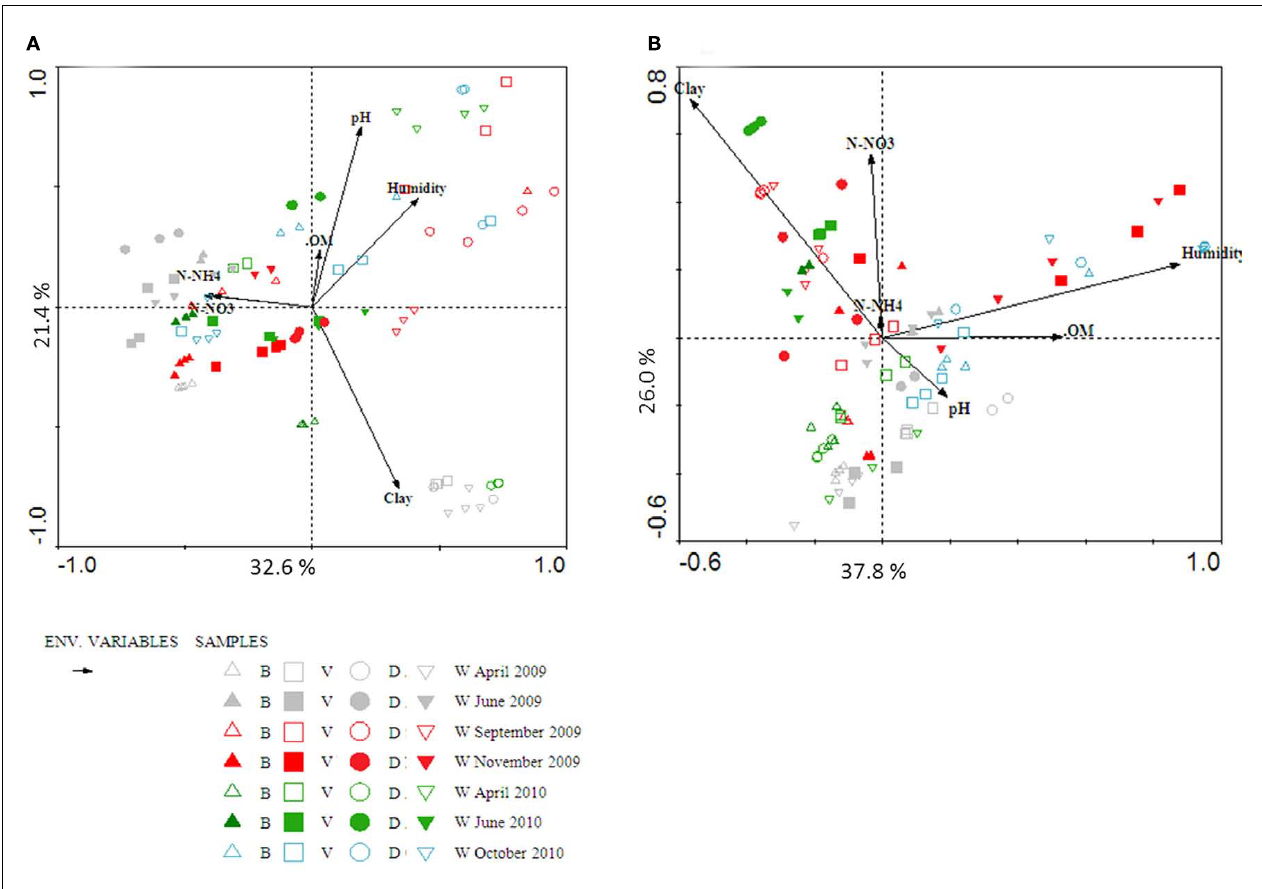
Physico-chemical data, soil moisture (Humidity), soil nitrate (N-NO 3 ), soil ammonium (N-NH 4 ), organic matter (OM), clay content (clay), soil pH (pH) are presented with black